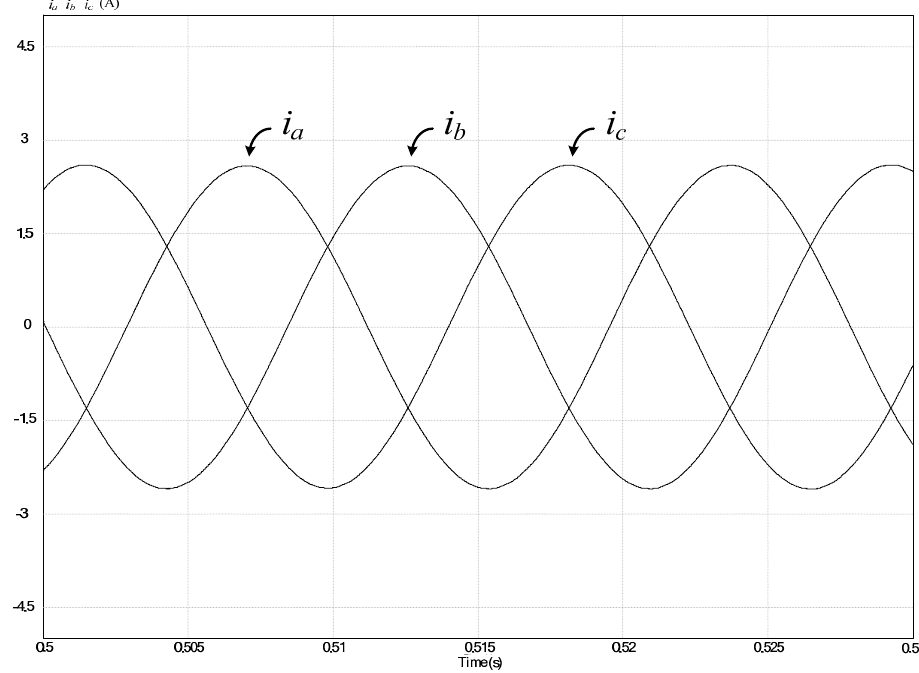
Figure 3. Output waveforms of line currents for an inverter working at 60 Hz without any faulty switches.